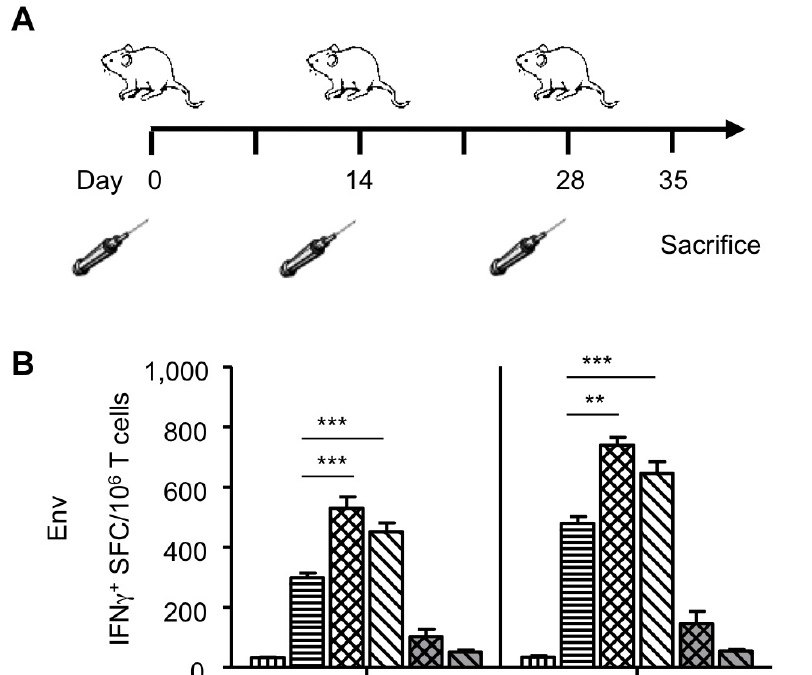
Figure 2. Transcription factor adjuvants enhance antigen specific DNA vaccine induced T cell immunity. ( A ) Balb/C mice ( n= 4 /group) were vaccinated three times at two